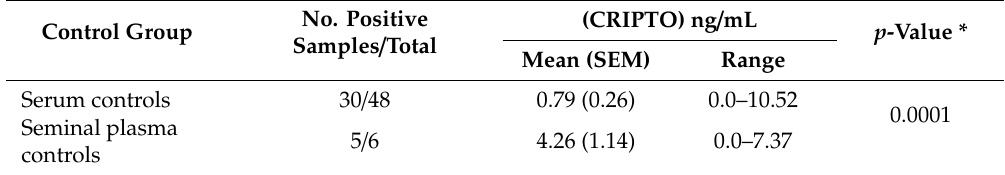
* p -values refer to the comparison between both control groups (serum vs. seminal plasma). Abbreviations: SEM—standard error of mean.